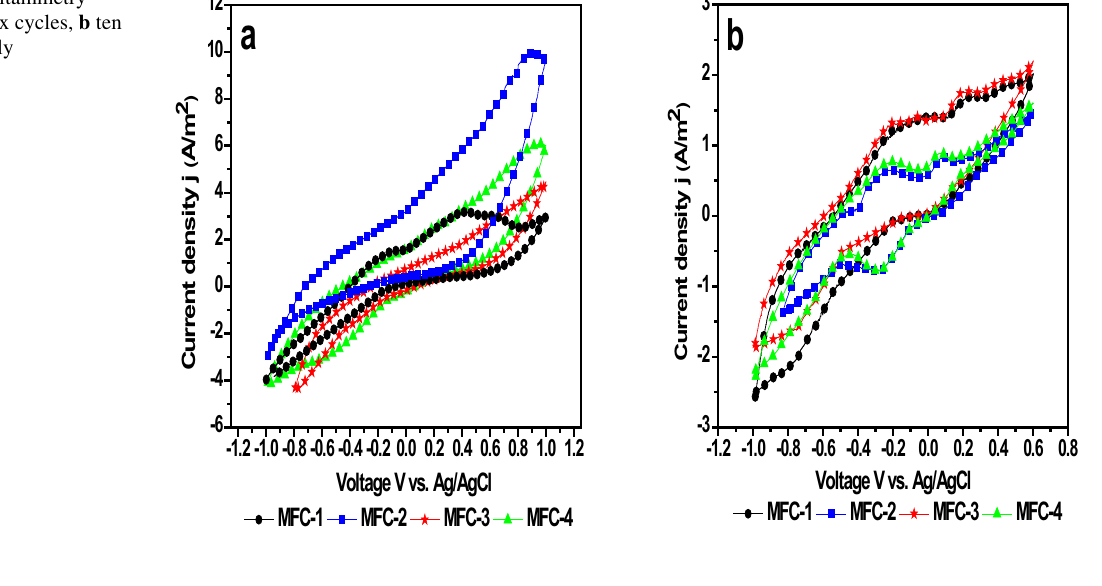
Fig. 6 Cyclic Voltammetry obtained after a six cycles, b ten cycles,